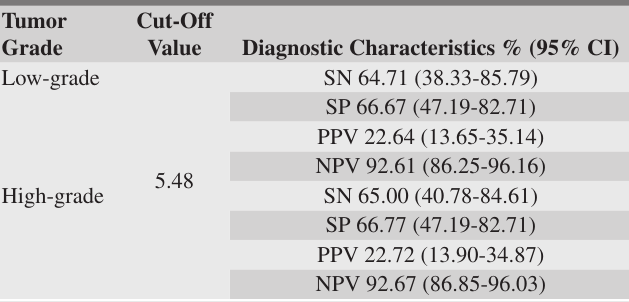
Table 3. Overall Sensitivity, Specificity, Positive Predictive Value, and Negative Predictive Value of AHNAK2 accord- ing to tumor grade, with a cut-off value of